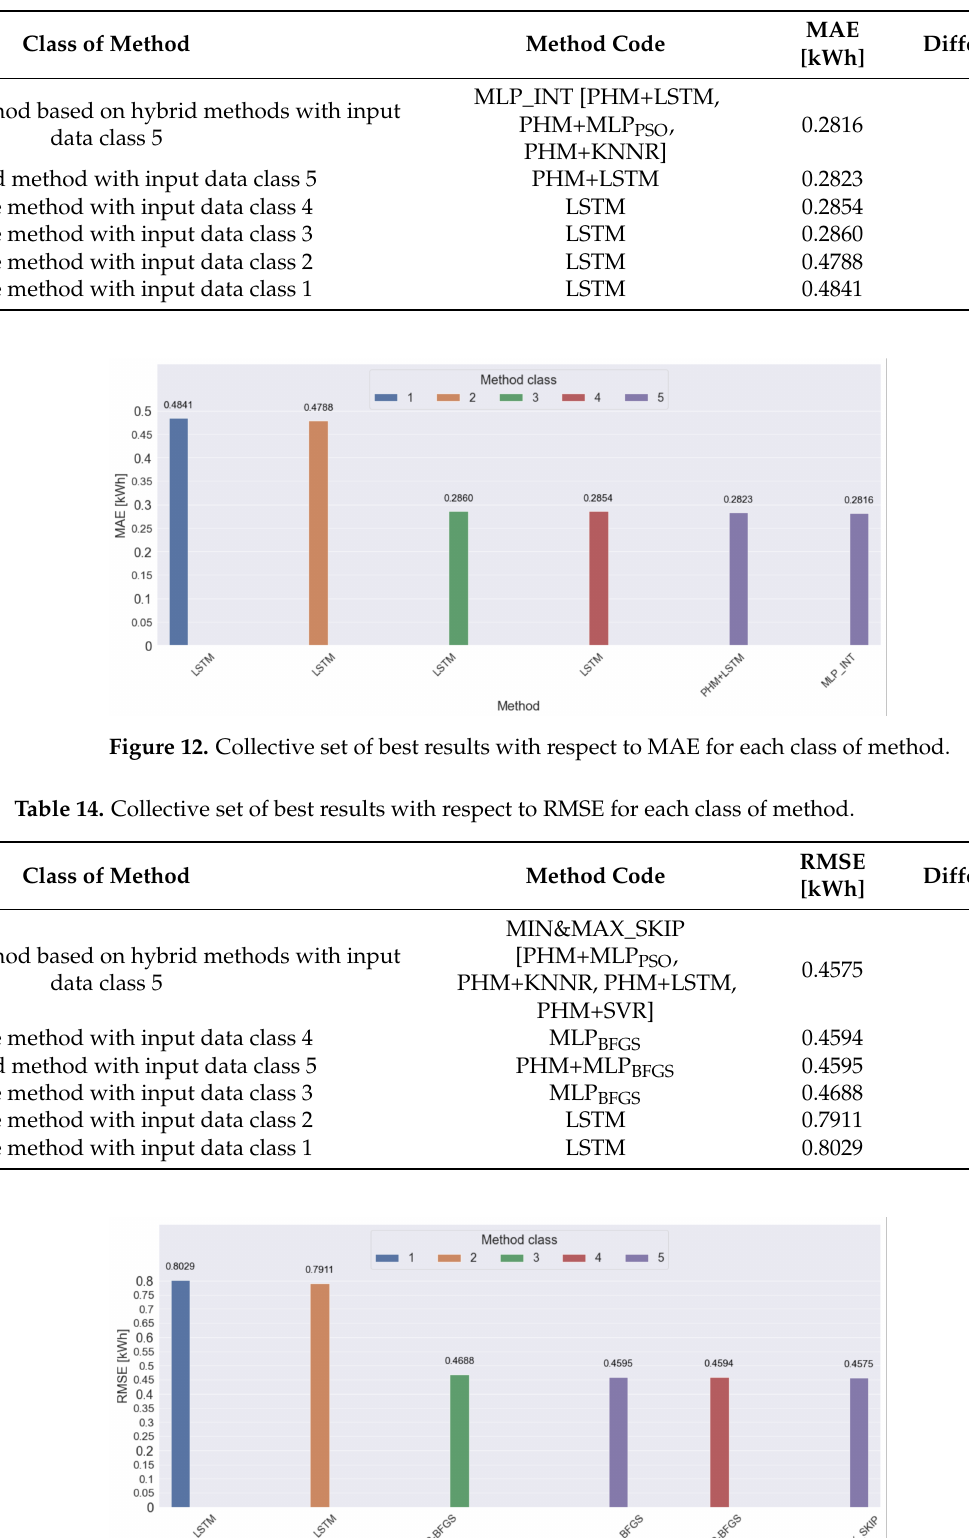
Table 13. Collective set of best results with respect to MAE for each class of method.